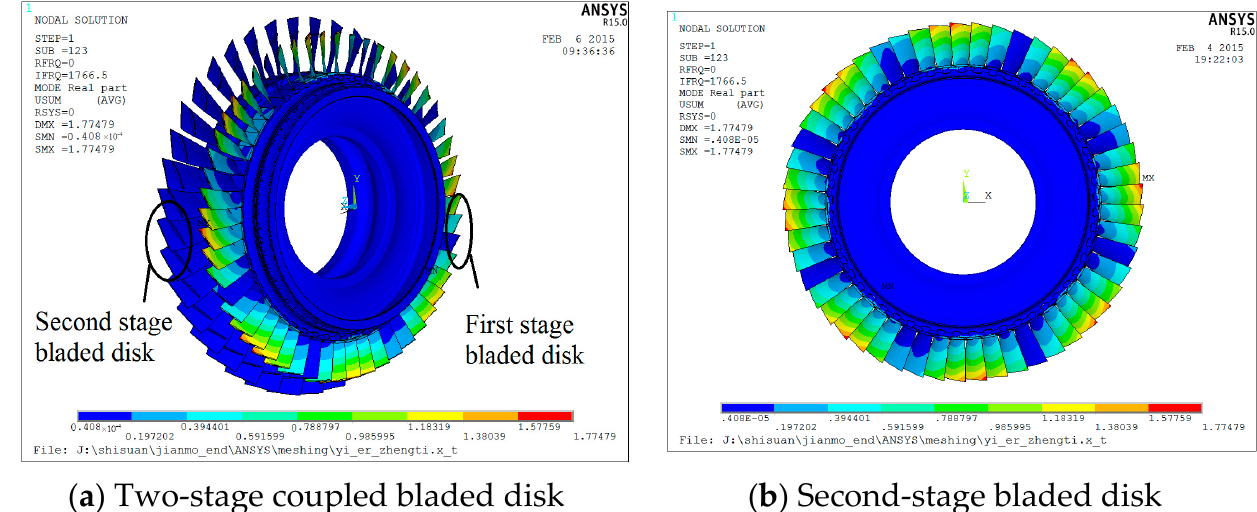
Figure 23. Coupled vibration of the blade and disk in three segments.